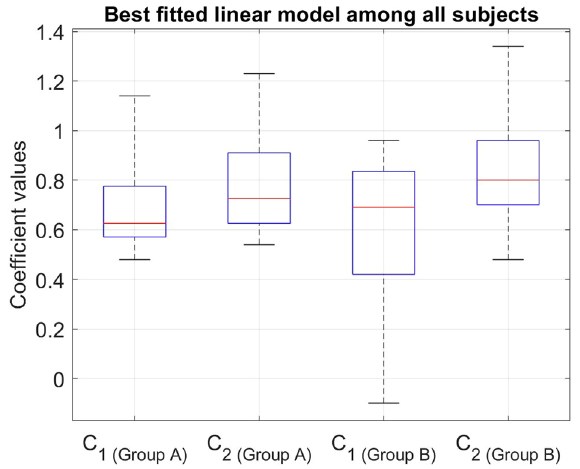
Figure 5. Whisker plot of coefficients for individual linear